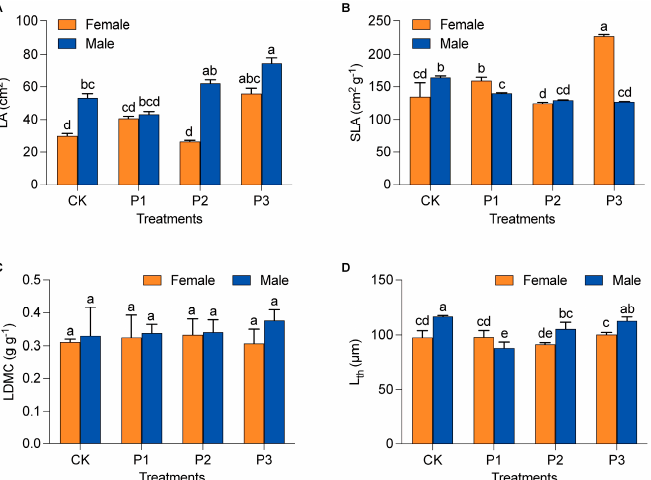
Figure 1. The leaf area ( A ), specific leaf area ( B ), leaf dry matter content ( C ), and leaf thickness ( D ) of L. cubeba female and male leaves under control and Pb treatments. Leaf area, the projected area of a leaf; Specific leaf area, the leaf dry − mass per unit of the leaf area. CK, P1, P2, and P3 represent 0, 1, 2, and 3 mmol Pb/kg dry soil, respectively. Values are the mean of three replicates ± SE. Values followed by different lowercase letters significantly differed, according to Duncan’s test ( p <